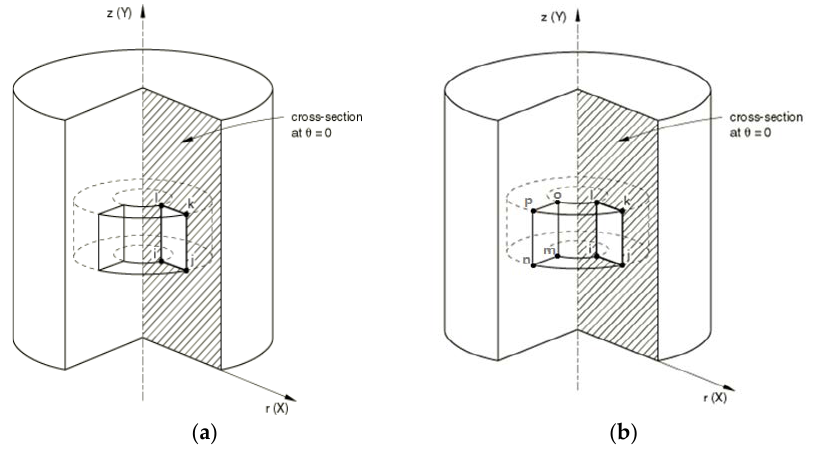
Figure 2. Reference cross-section and axisymmetric solid elements: ( a ) 4-nodes ( b ) 8-nodes [19].